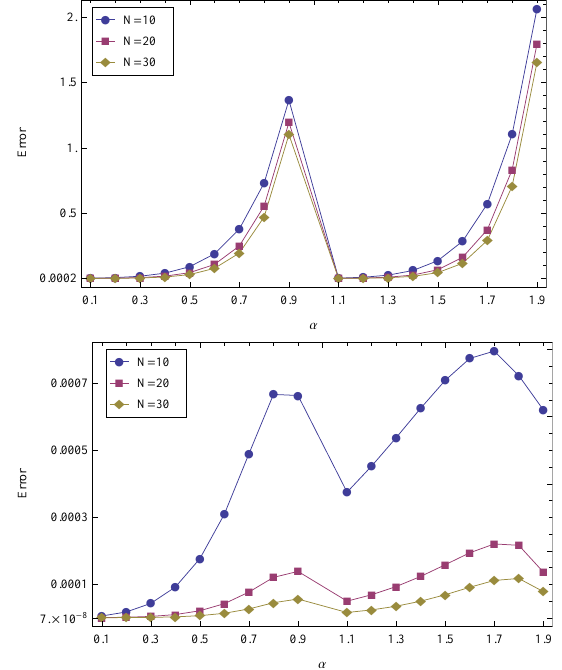
Fig. 1: Maximum absolute errors E α for the function y ( x ) = x 5/2 by using (4.18) (left) and by using (4.20)